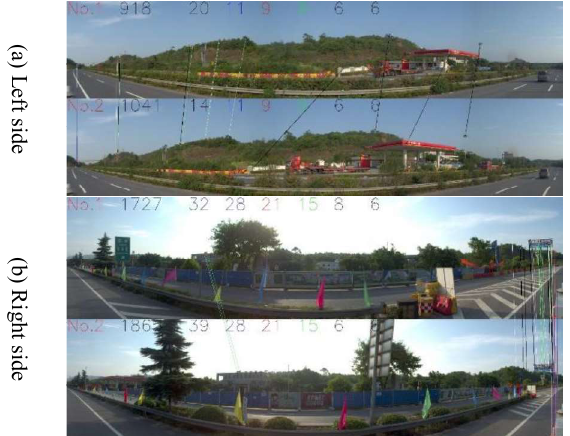
Figure 7 . Feature points matching of No.1-2 in dataset